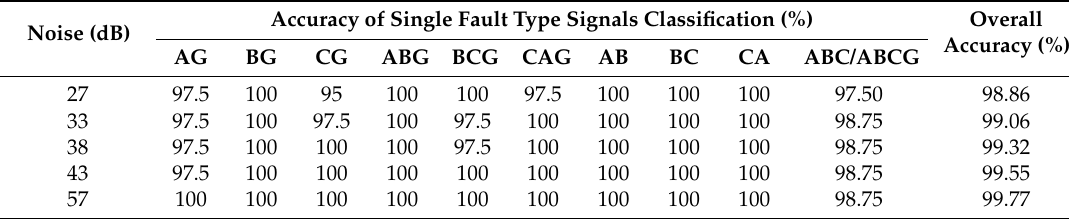
Table 8. Classification accuracy of the proposed method with signal adding different